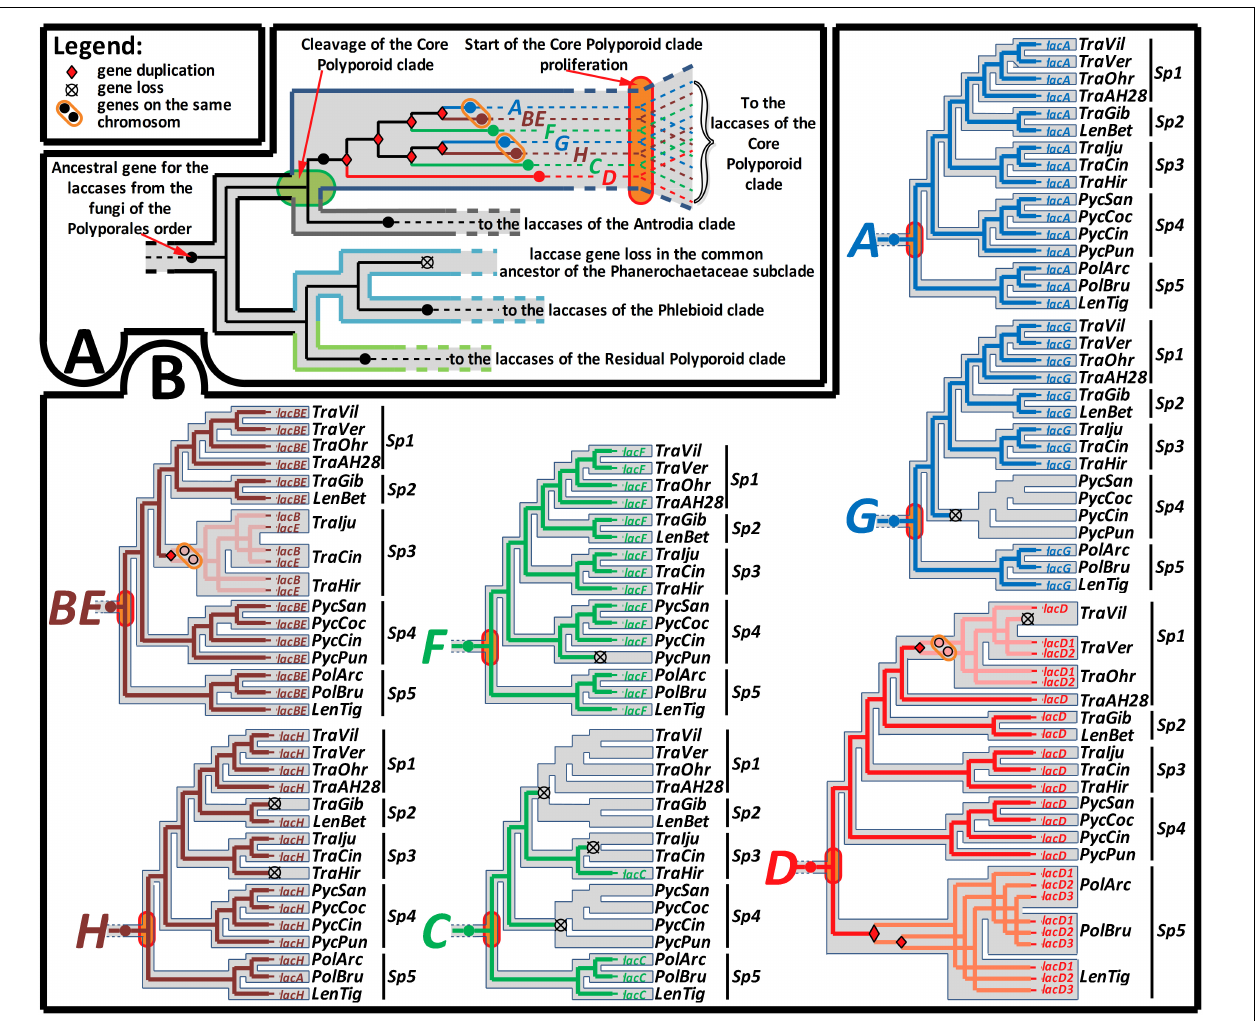
FIGURE 3 | Summary of the gene-tree/species-tree reconciliation analysis. The relative sequence of events in the evolution of the laccase gene family from the fungi of the Polyporales order, recovered by the synteny-aware gene-tree/species-tree most parsimonious reconciliation procedure. For the symbols that marked gene loss and duplication events and location of the duplicated genes on the same chromosome, refer to the figure legend. (A) Represents the early sequence of evolutionary events from the emergence of the Polyporales order until its splitting into four main clades. Special emphasis is placed on the detected multiple gene duplications in the core Polyporoid clade, which occurred between its cleavage and start of proliferation. (B) Represents the detailed sequence of evolutionary events from the start of the core Polyporoid clade proliferation until the present. The evolutionary history of each duplicated copy (A–H) of the ancestral gene is separately mapped onto the relevant part of the species-tree (see Figure 1 ). Simultaneous mapping of all seven genes can be found in the Supplementary Figure S2 . For the fungal species abbreviations, refer to Figure 1